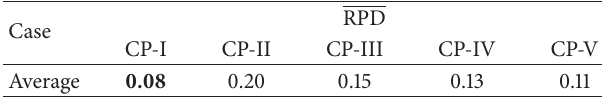
Table 4: Comparisons of different crossover probabilities.